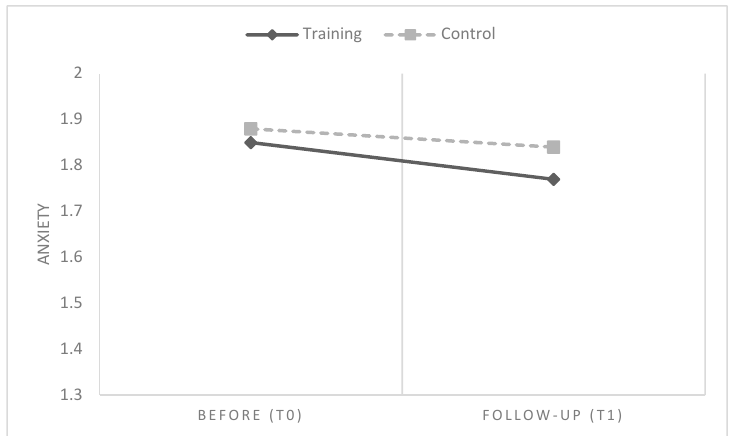
Figure 3. Mean differences between groups and time in anxiety.